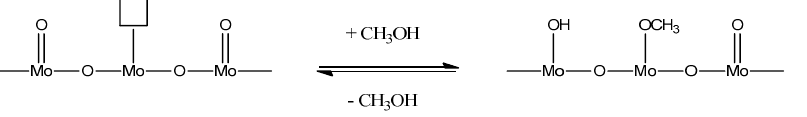
Figure 15. Dissociative chemisorption of methanol on α -MoO 3 [49]. The dual acid-base sites are formed from an unsaturated metal cation (O–Mo–O), and adjacent terminal oxygen (Mo = O) [47]. Methanol can dissociatively chemisorb at these dual sites. The unsaturated Mo atom performs as a Lewis acid centre, acting as the adsorption site for a methoxy intermediate. The basic M = O site abstracts a proton simultaneously to form a hydroxyl. Both intermediates have been evidenced through IR studies